Question: Which visualization type does this figure use?
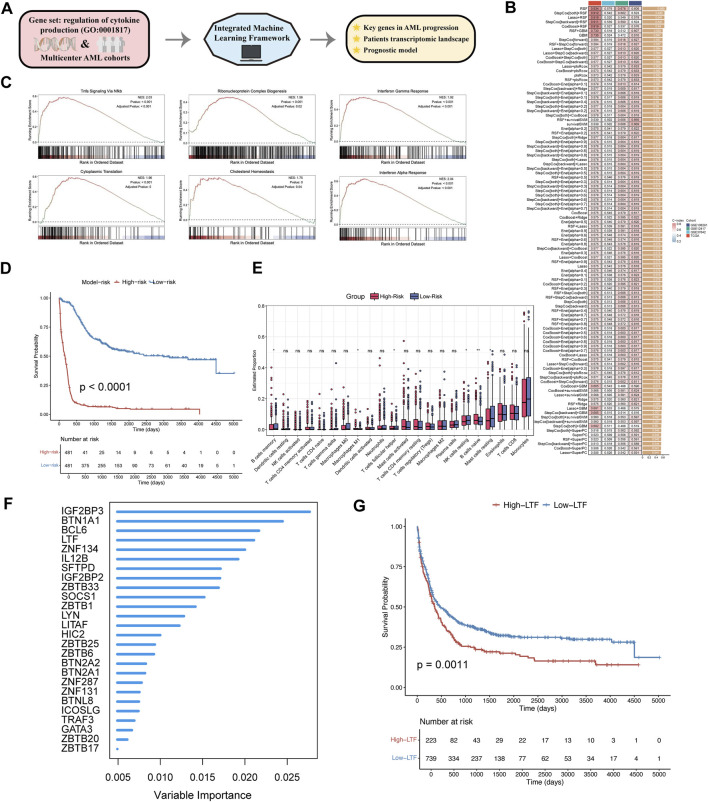
Answer: survival